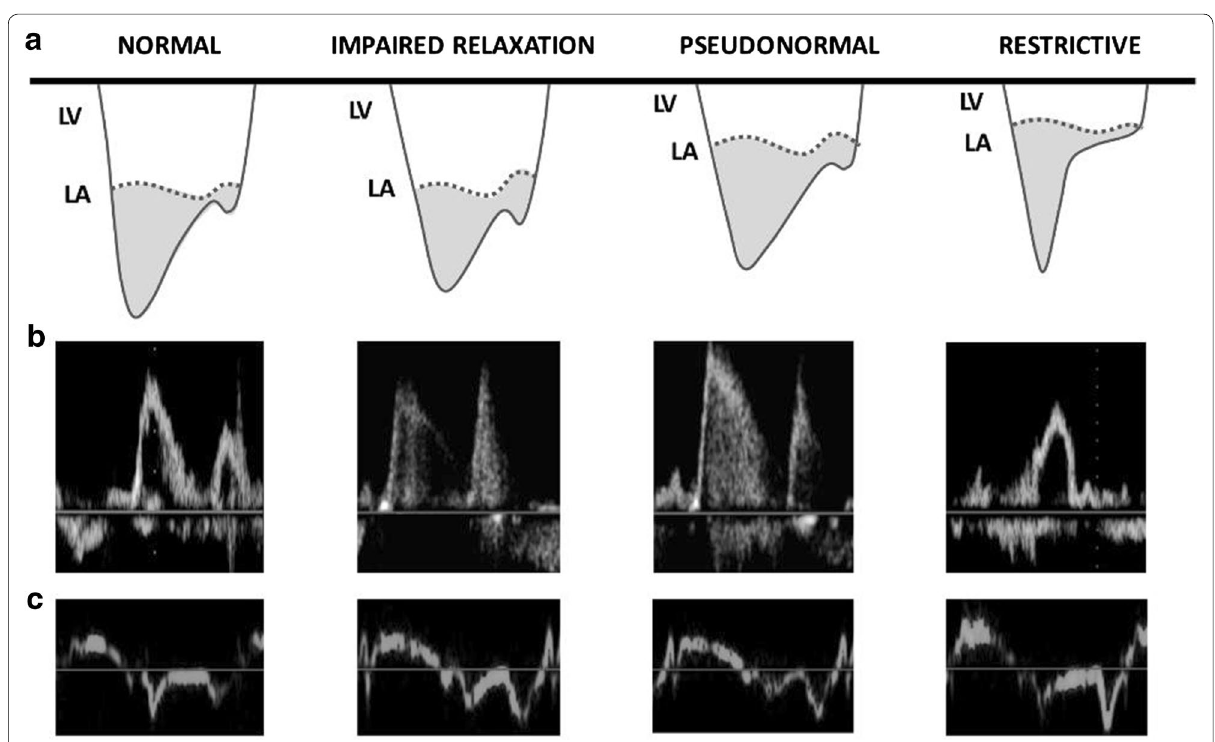
Fig. 1 Progression from normal diastolic function to worsening degrees of left ventricular diastolic dysfunction (LVDD). The top row a illustrates the respective changes in left atrial (LA) and left ventricular (LV) pressures with the progression of LVDD. The middle and bottom rows show examples of the patterns of transmitral blood flow ( b ) and of tissue Doppler imaging of the mitral annulus ( c ). These patterns are shown for each stage of LVDD, with corresponding changes of the E and e ′ (early), and A and a ′ (atrial) waves. From left to right, 2a: normal diastolic function ( E > A ; e ′ > a ′ ); 2b: LVDD grade I ( E < A ; e ′ < a ′ ); 2c: LVDD grade II ( E > A ; e ′ < a ′ ); 2d: LVDD grade III ( E ≫ A ; e ′ ≪ a ′